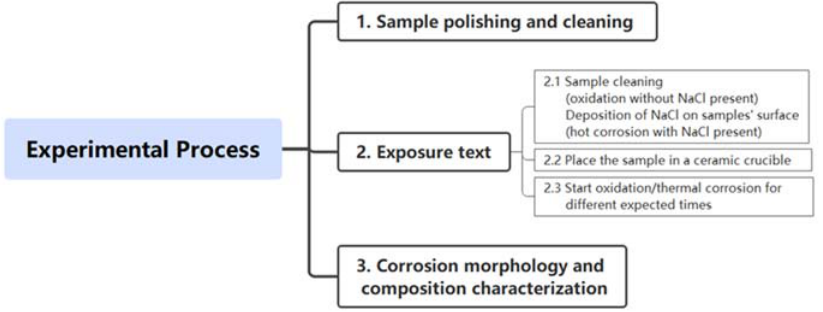
Figure 2. the scheme of experiment process.